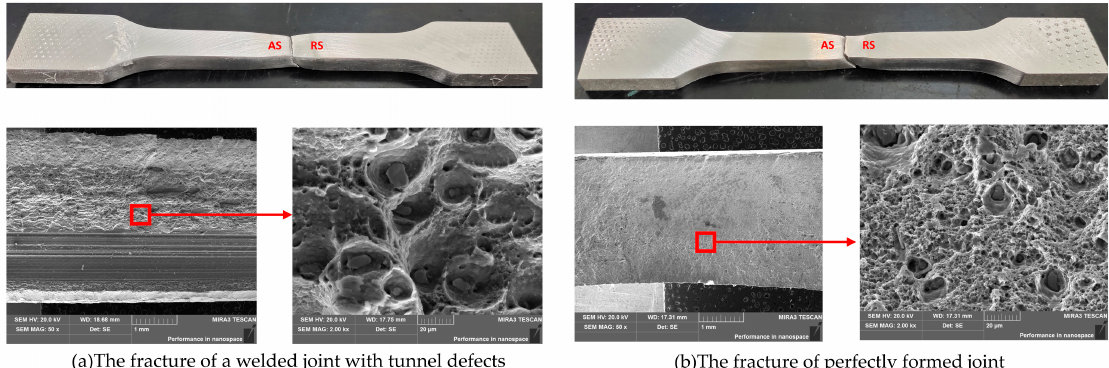
Figure 8. Temperature signal component of welds with improper process: ( a ) Temperature signal component decomposed by wavelet packet at node 7; ( b ) Spectrum of temperature signal component at node 7; ( c ) Temperature signal component decomposed by wavelet packet at node 8; and ( d ) Spectrum of temperature signal component at node 8.